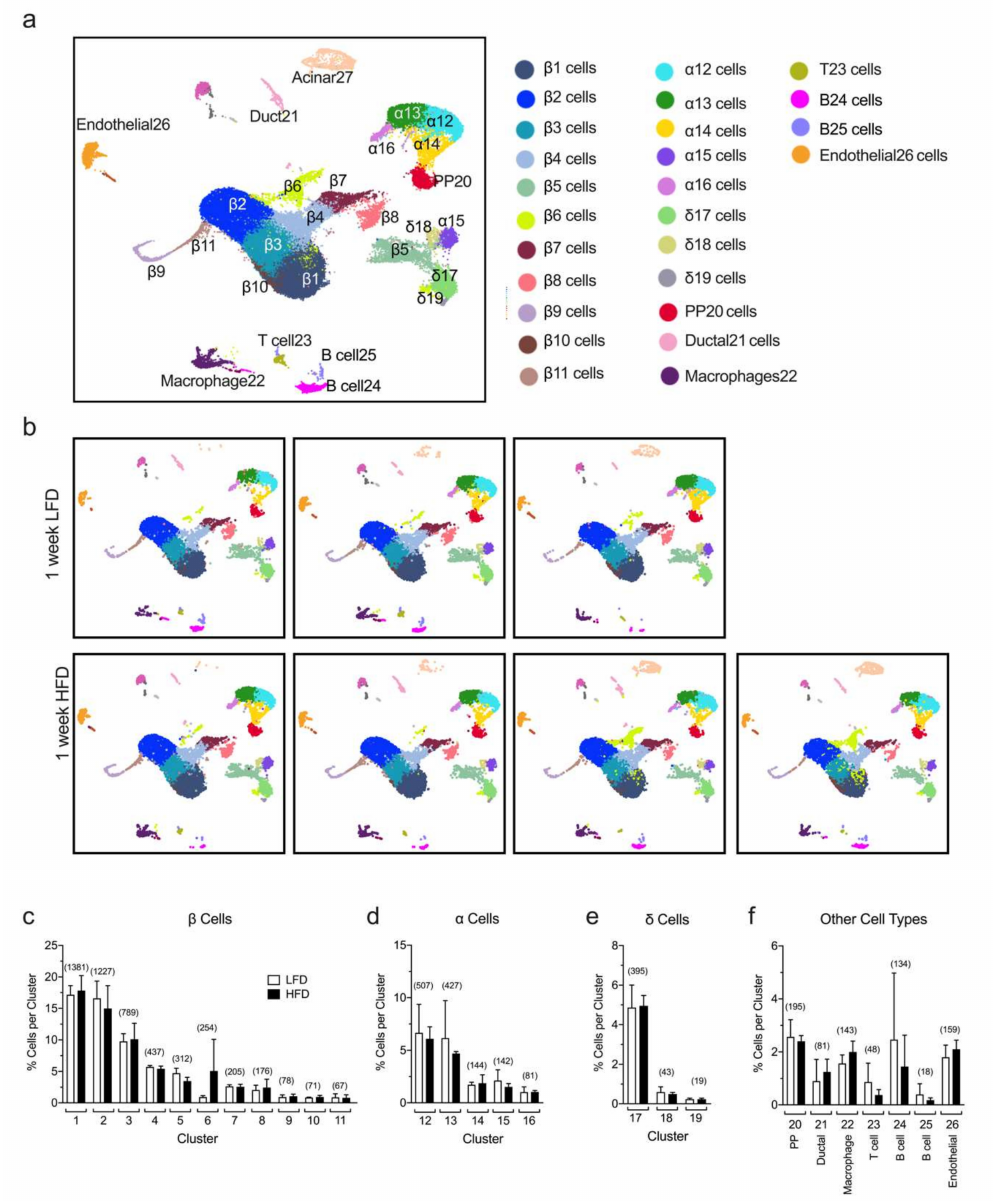
Figure 1. Identification of islet cell type clusters by single-cell RNA sequencing. Single cells were obtained from dissociated islets from male C57BL / 6J mice fed for one week with either a high-fat diet (HFD, 60% kcal from fat, n = 4) or a control low-fat diet (LFD, 10% kcal from fat, n = 3) and used to perform single-cell RNA sequencing. ( a ) Annotation of islet cell types into di ff erent clusters based on the expression of key identifying genes, depicted in the Uniform Manifold Approximation and Projection for Dimension Reduction (UMAP) plots of merged sc-RNAseq profiles from LFD and HFD mice; ( b ) UMAP of single-cell RNA sequencing profiles from islets of individual mice fed a HFD or a LFD, as indicated; In ( c–f ), the percentage of β cells ( c ), α cells ( d ), δ cells ( e ), and other cell types ( f ) identified per cluster relative to the total number of cells sequenced is shown. Data are mean ± SEM, n = 3 for LFD and n = 4 for HFD. The number in the parentheses above each bar indicates the average number of cells per